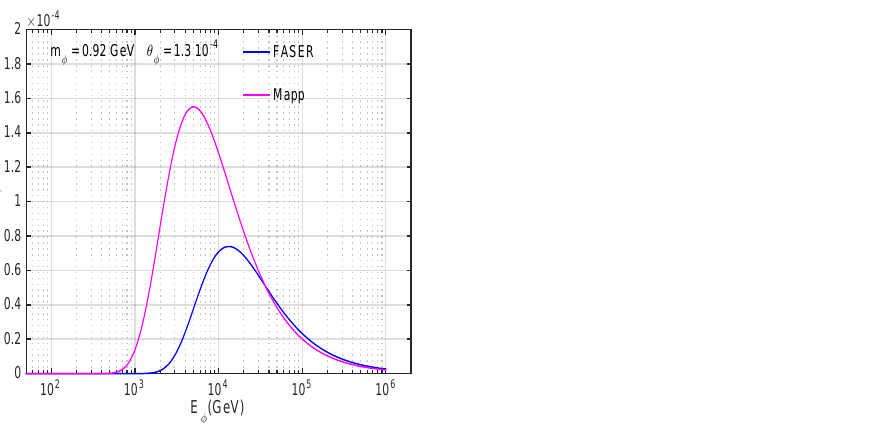
Figure 7. The evolution of the normalised detection probability P det ( E ϕ , θ α ) with the dark Higgs energy E φ corresponding to FASER and Mapp experimental configurations, obtained for the cosmo- logical best fit solution for m ϕ and θ